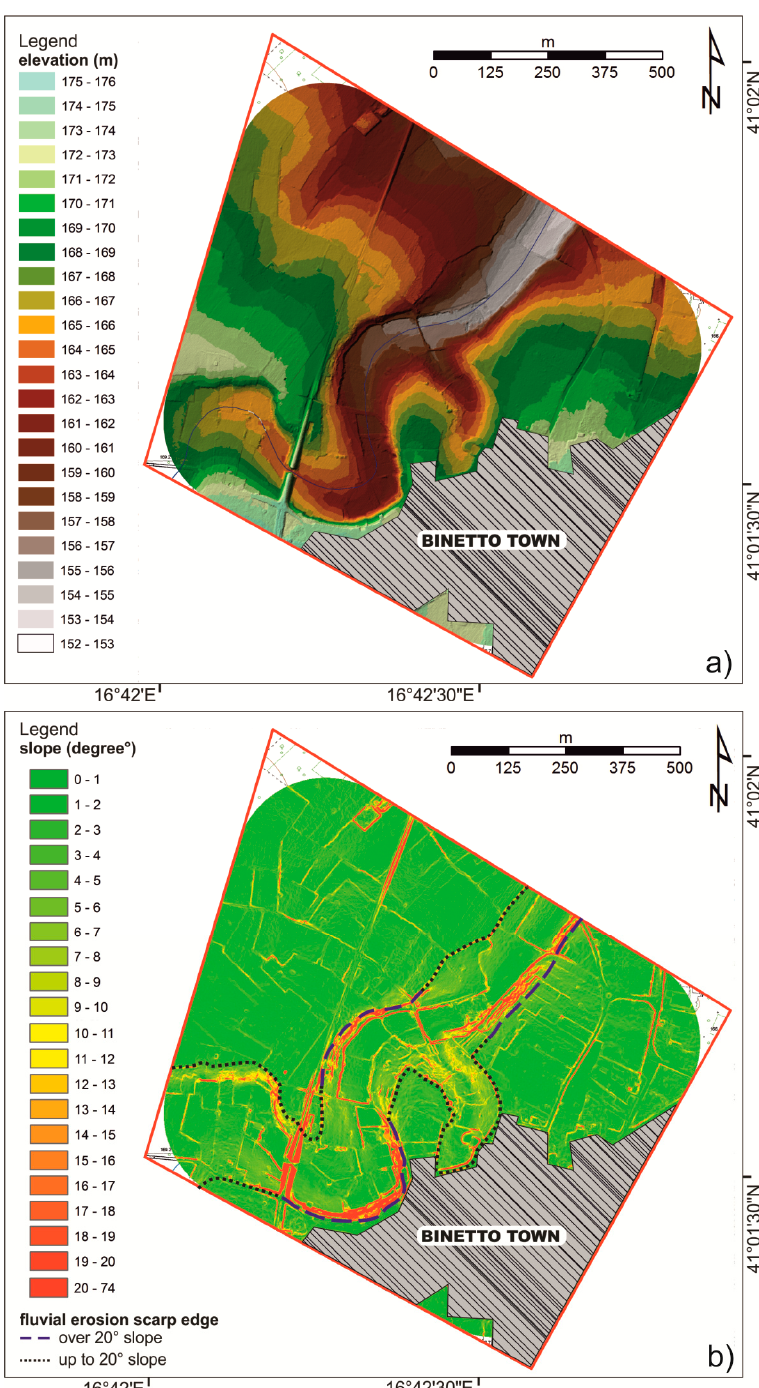
Figure 7. ( a ) Triangulated irregular network (TIN) model based on a high-resolution digital surface model (DSM) (1 m per cell). Note the occurrence of some graphical artifacts related to slope peaks along the main anthropogenic elements; the dotted gray area indicates the Binetto Town (see Figure 4 for a comparison), where the approach adopted for the automatic landform classification is not suitable. ( b ) “Slope raster” model based on a high resolution DSM (1 m per cell). The slope peaks highlight the morphological scarps mapped along Lama Lamasinata. Some graphical artifacts related to slope peaks in correspondence of the structure of the roads and related dry-stone-walls were also observed; the dotted gray area indicates the Binetto Town (see Figure 4 for a comparison).